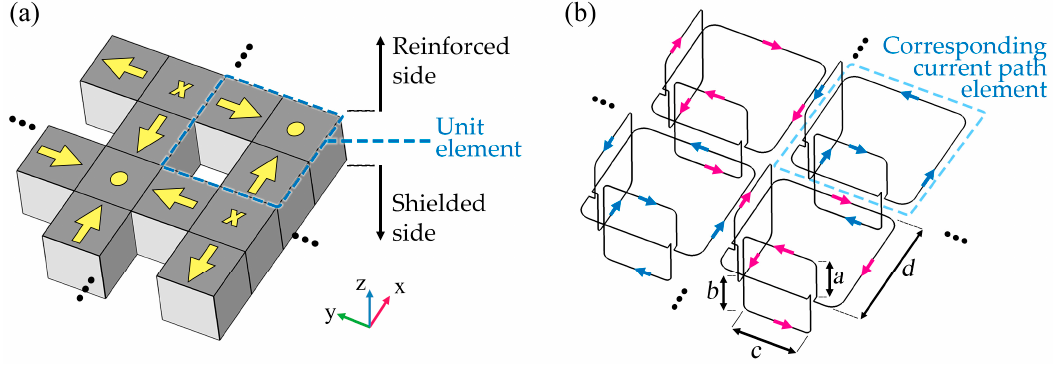
Figure 3. The geometry of the introduced 3D structure that represents an element of the planar array. The array may be extended in both x and y directions.